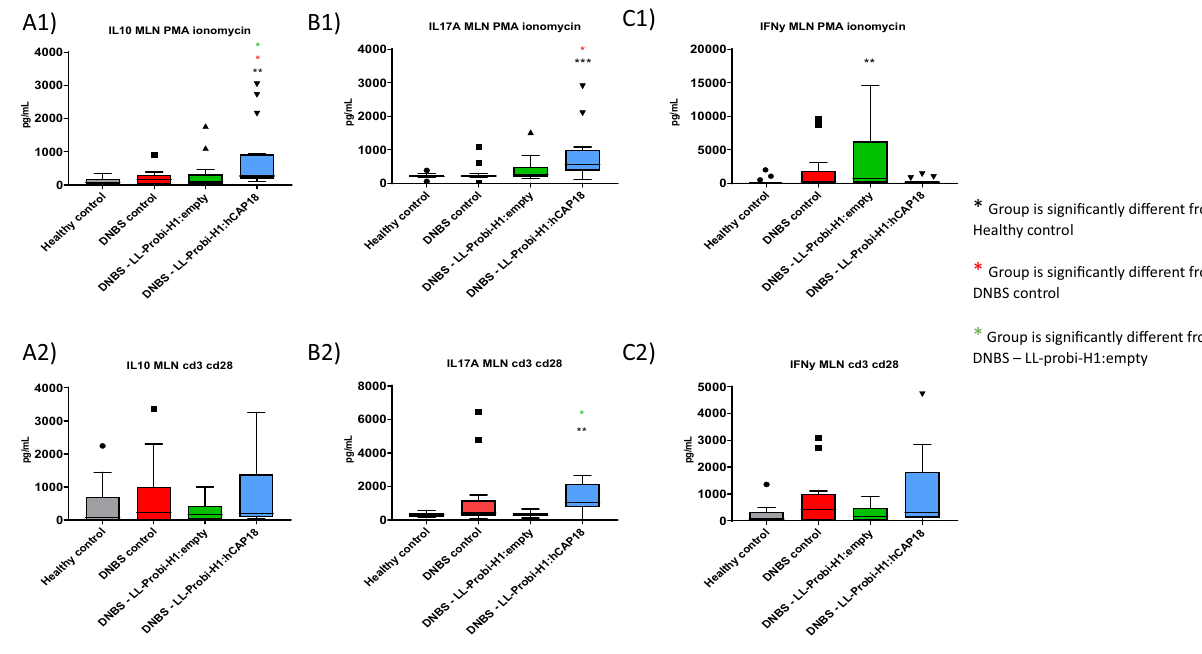
Figure 4. Cytokine concentrations in mesenteric lymph node supernatants. Cytokine secretion by mesenteric lymph node cells was induced with PMA ionomycin ( A1 , B1 , C1 ) or CD3+/CD28+ ( A2 , B2 , C2 ), A = IL-10, B = IL-17A, C = IFN-γ. Box and whiskers were plotted using the Tukey method. Statistical significance was determined by Kruskal–Wallis with Dunn’s multiple comparison test. *P < 0.05, **P < 0.01, ***P < 0.001,